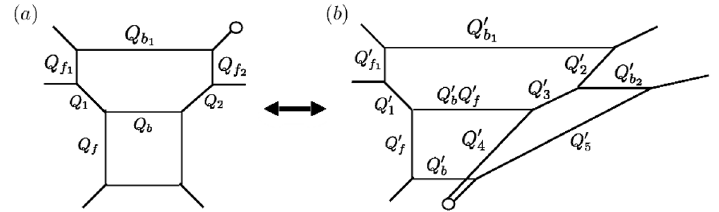
Figure 17 . The web diagrams which are dual each